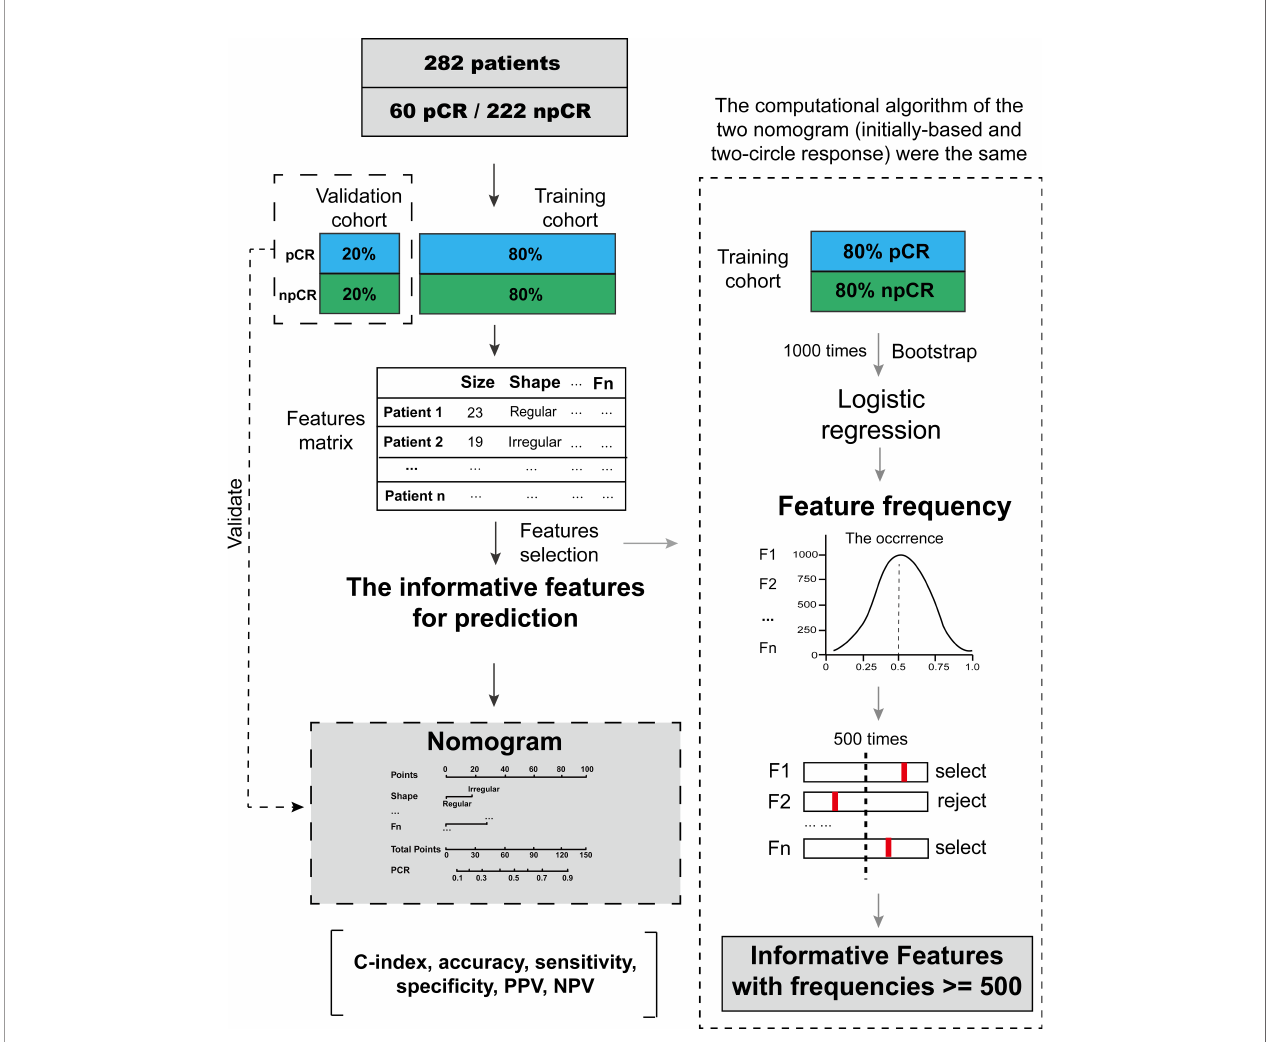
FIGURE 2 | Step-by-step protocol for the nomogram computational